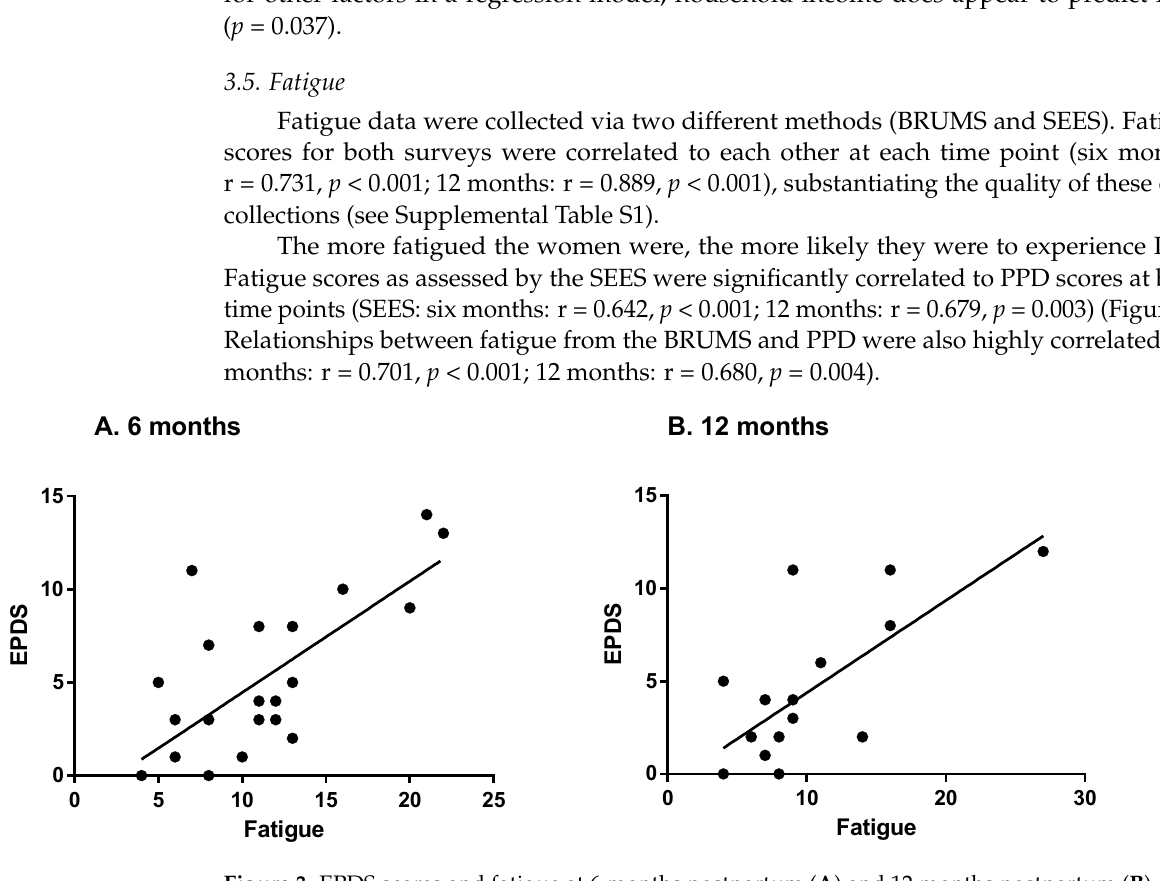
Figure 2. Mean ± SE EPDS Scores at Six Months Postpartum between pre-pregnancy BMI categories; ——- signifies indicator for possible PPD.